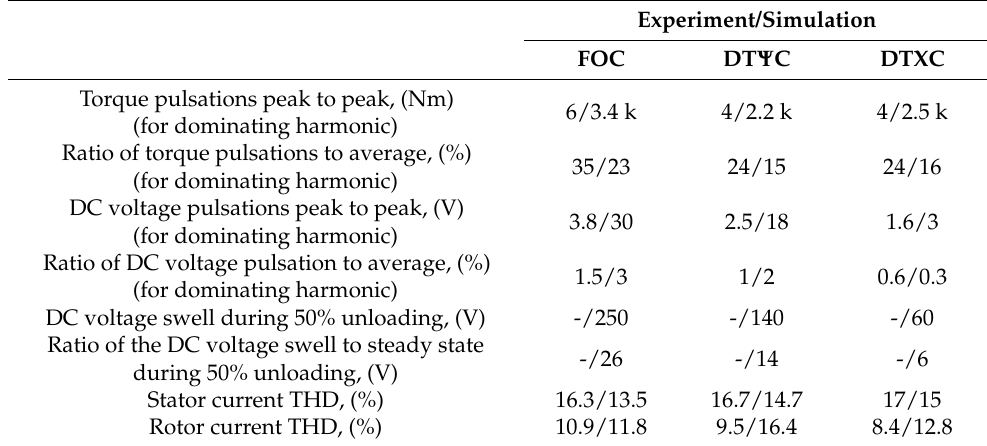
Table 1. Torque and DC Voltage Pulsations Obtained in Simulation and